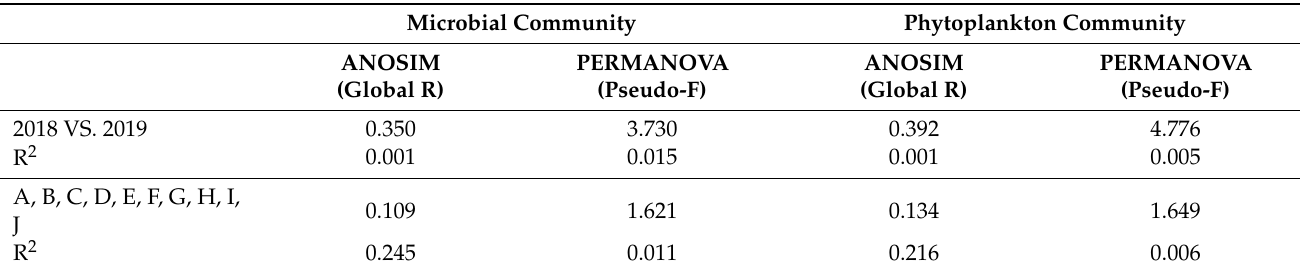
Figure 5. Shade plot illustrating the microbial communities at the phylum level by sites for 18 samples. The plot depicts the relative abundance of phyla within microbial communities. **: >1,000,000 copies/mL (rDNA of C. polykrikoides ) . Table 6. Analysis of similarities (ANOSIM) and PERMANOVA results for years and